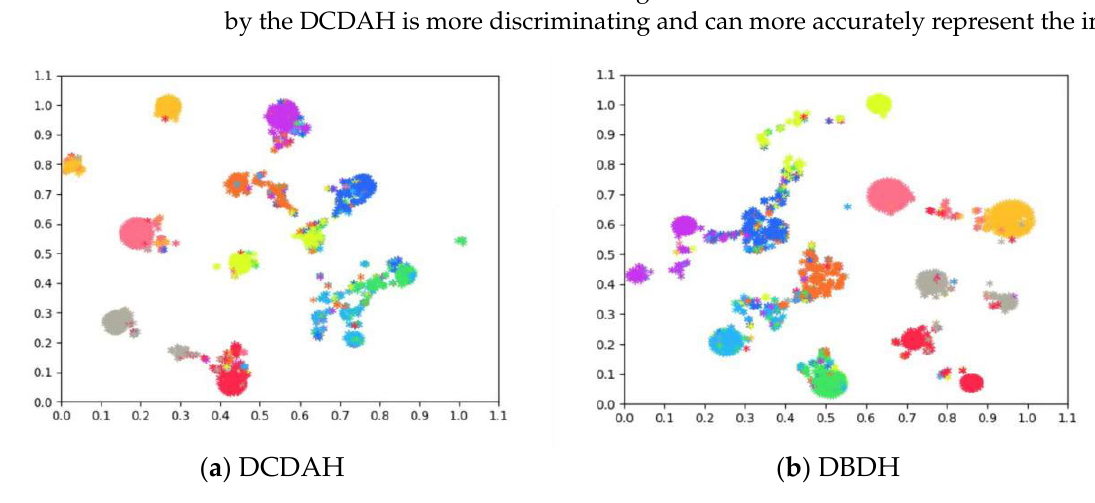
Figure 10. Hash code visualization results.